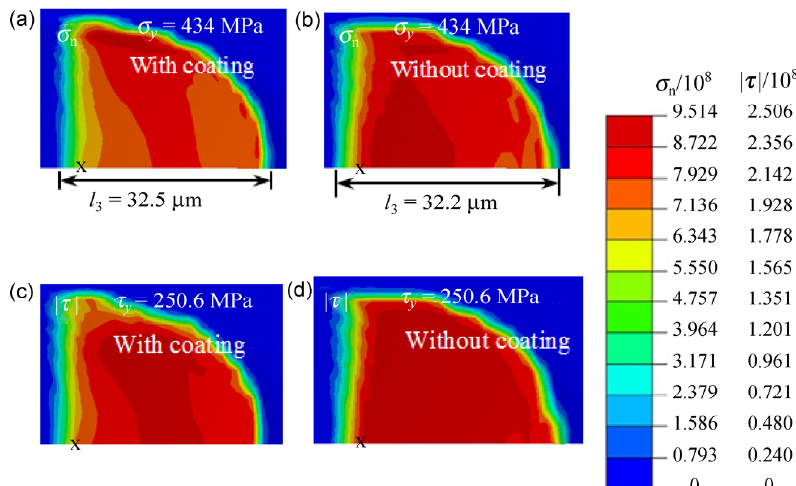
Fig. 4 Distributions of the magnitude of friction stress | |  and normal contact pressure σ on the contact surface of a coating with n 434 MPa   during scratch under axial force 0.8 N F  , with a substrate ( 334 MPa in (a) and (c) and 434 MPa in (b) and (d))     n y y y In (b) and (d), the yield strengths of coating and substrate are the same, which corresponds to the case: “without coating”. The location of indenter tip is marked by a small